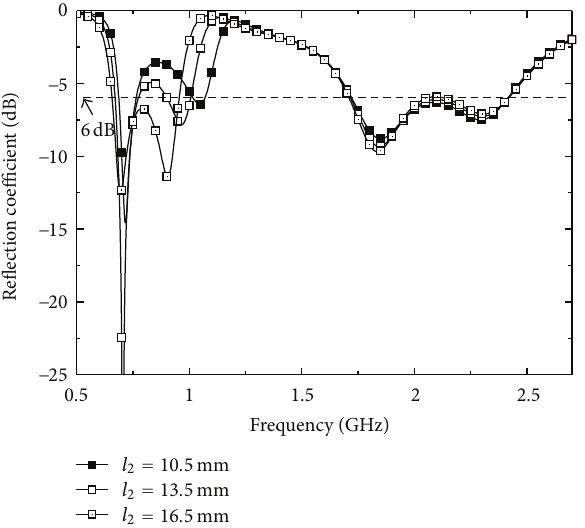
F 5: Simulated re�ection coe�cients relative to changes in the length of the part generating the coupled feed